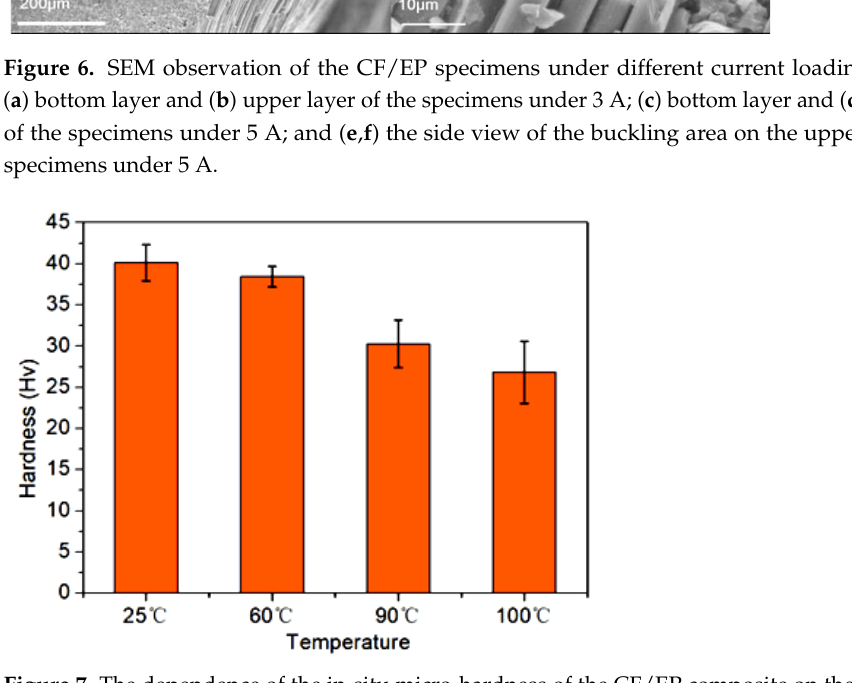
Figure 7. The dependence of the in-situ micro-hardness of the CF/EP composite on the temperature.